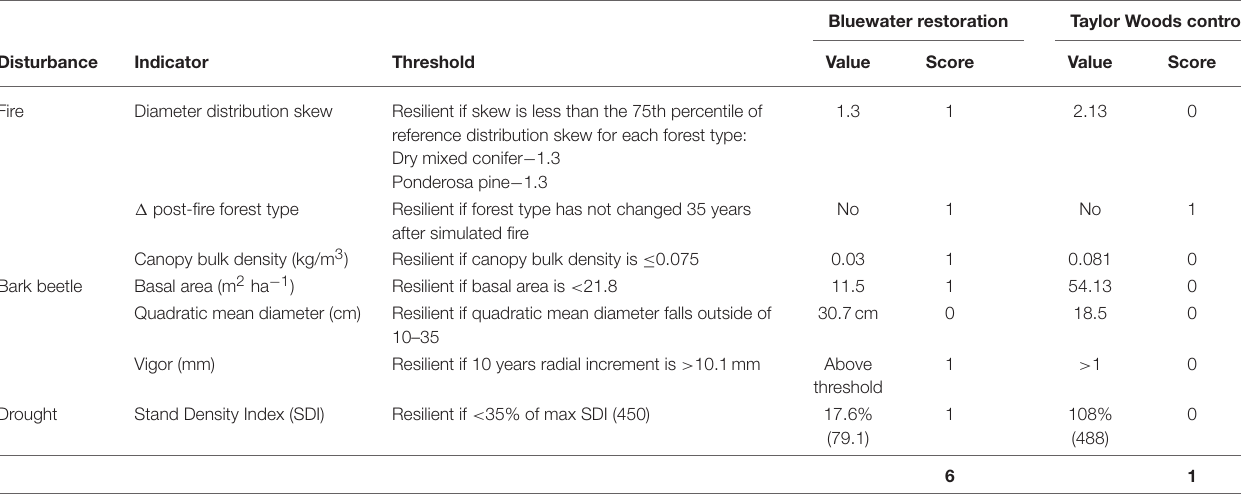
TABLE 3 | Indicator values and overall resilience score in the ponderosa forest type from the Bluewater Demonstration Site, Cibola National Forest, New Mexico (Reynolds et al., 2013) and experimental control plot at Taylor Woods “Levels of Growth Study,” Fort Valley experimental Forest, Coconino National Forest, Arizona.